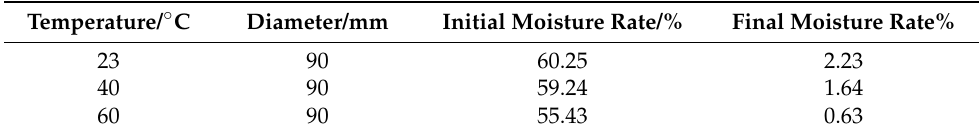
Table 6. Measurement results of water content of Guilin Red Clay at different